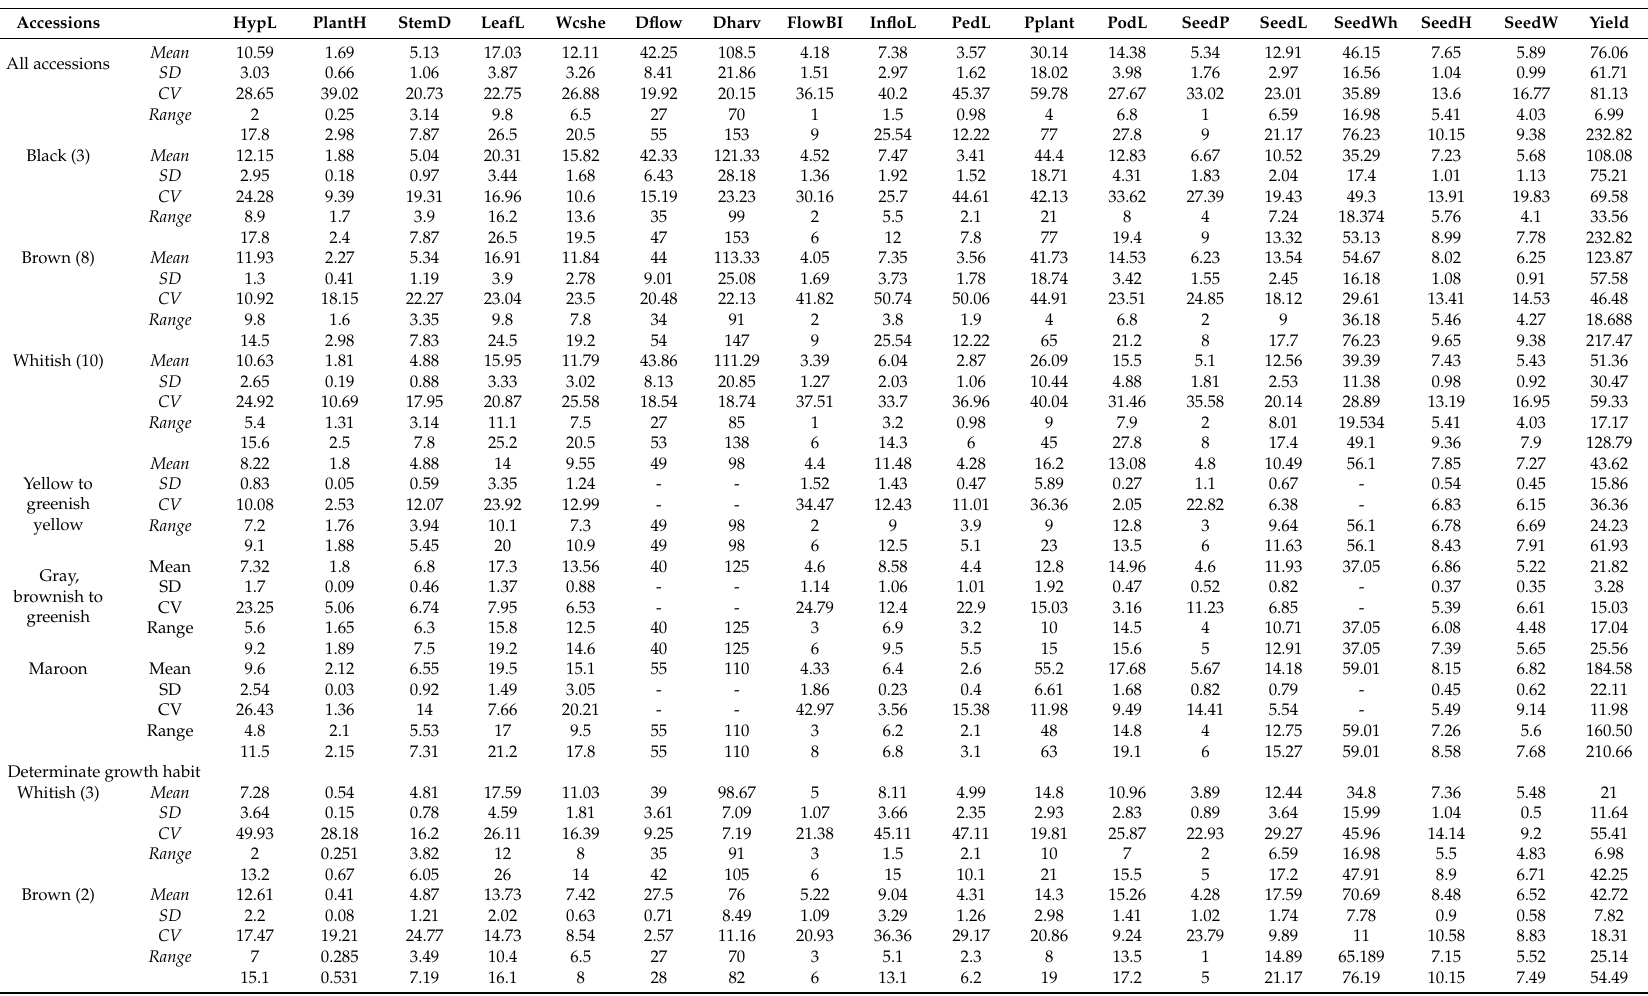
Table 5. Descriptive statistics for quantitative traits in each of the established groups and the whole set of accessions (number of accessions). Spring growing season Units of quantitative traits are as defined in Table